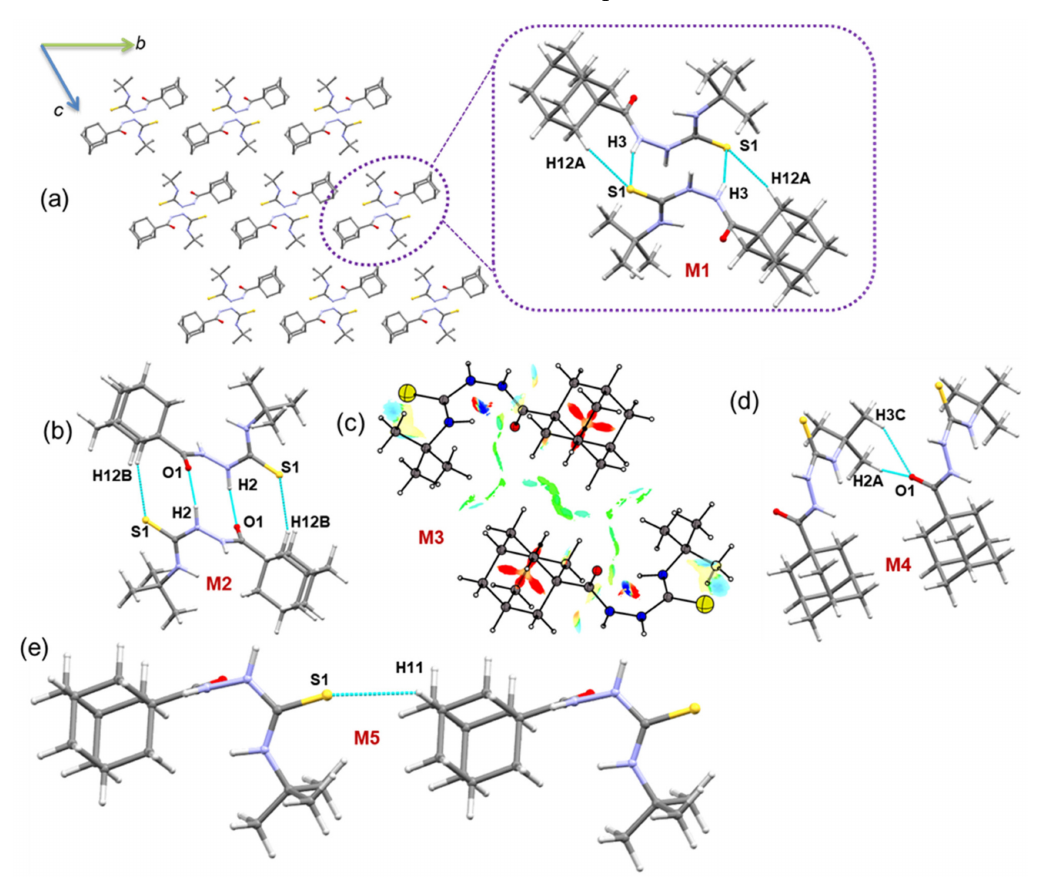
Figure 3. ( a ) Crystal packing of 1 and the primary structural motif M1 observed in this structure is shown (dashed box) and ( b – e ) other molecular dimers of 1 . The NCI plot is shown for molecular dimer